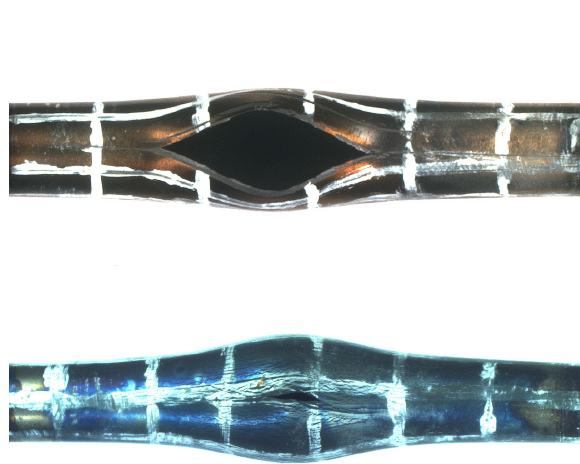
Figure 10. Coated specimen with Cr (above) and CrN+Cr (below) after exposure to 800 ◦ C and inner